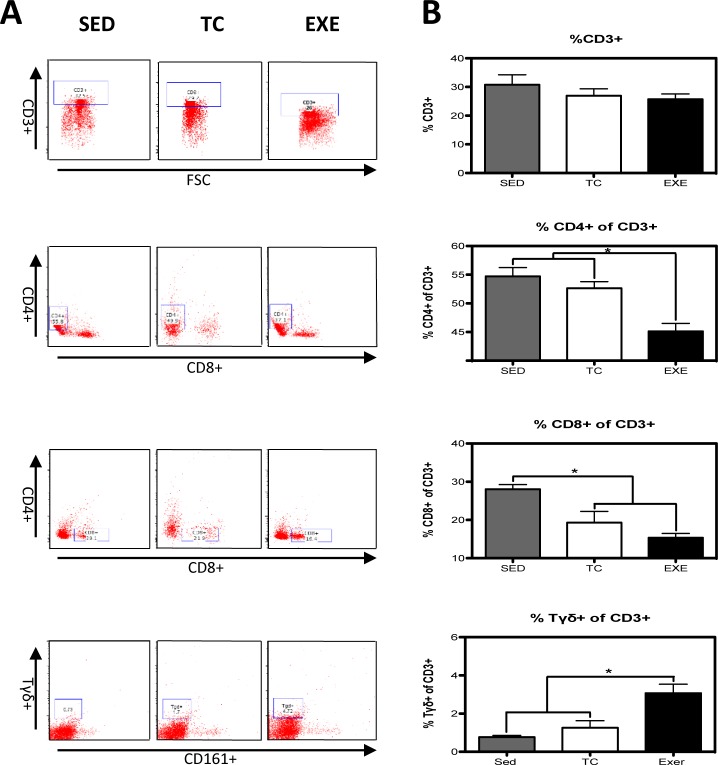
Changes in the composition of splenocyte populations related to the adaptive immune response.(A) Representative dot plot of the cytometric analysis of the subpopulation percentages. (B) Determination of splenocyte populations from the adaptive immune response in the different groups: SED, TC and EXE; data from 4 independent experiments are expressed as mean ± SE. Subpopulation that showed statistically significant changes were: T helper lymphocytes (ANOVA, p = 0.0008, n = 5) and Tγδ lymphocytes (ANOVA, p = 0.0002, n = 10). T lymphocytes (ANOVA, p = 0.3739, n = 12), cytotoxic T lymphocytes (ANOVA, p = 0.0016, n = 12). * Means statistically different from the two other groups, P<0.05.